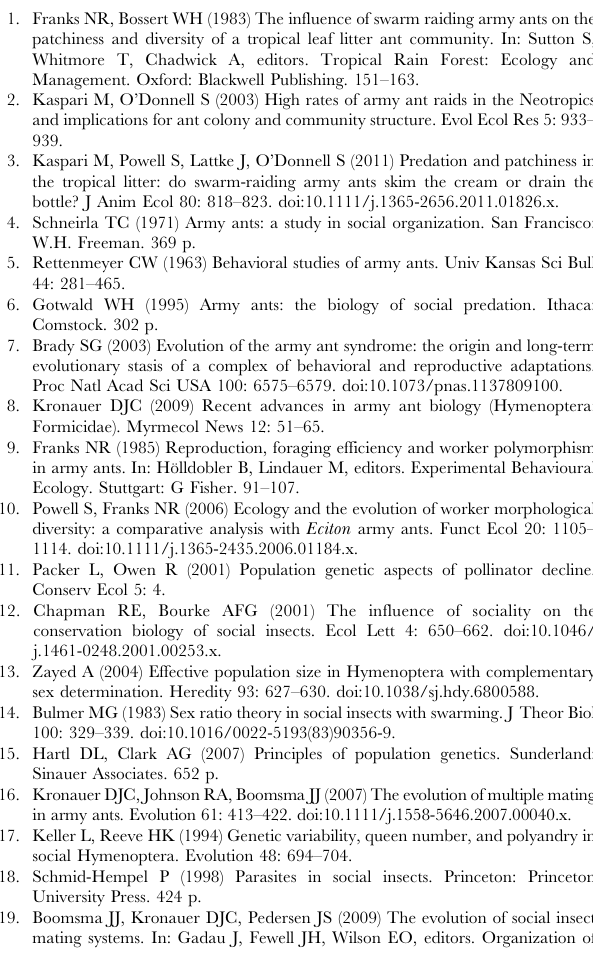
Table S2 Cross-amplification data of 14 microsatellite loci among five Neotropical army ant species. Table S3 Inferred queen and patriline genotypes of five Neotropical army